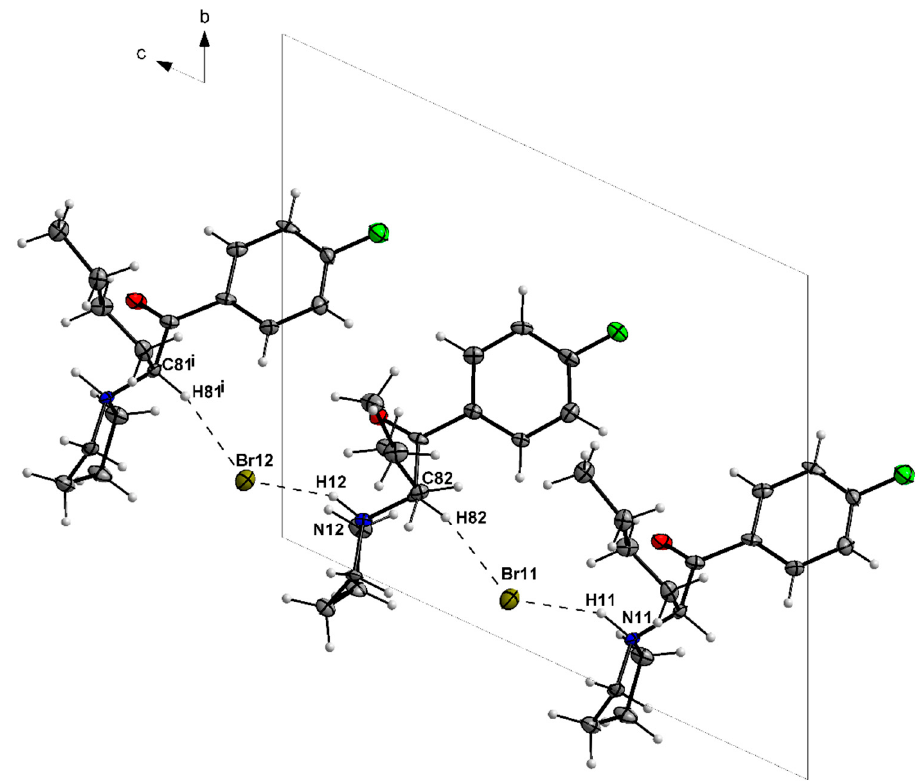
Figure 8. Part of the crystal structure of Compound 3 viewed along the a axis, showing H-bonding between neighboring ions (dashed lines). Symmetry code: (i) x , y , z − 1. Table 4. Hydrogen-bond geometry (Å,°) for Compound 3 .